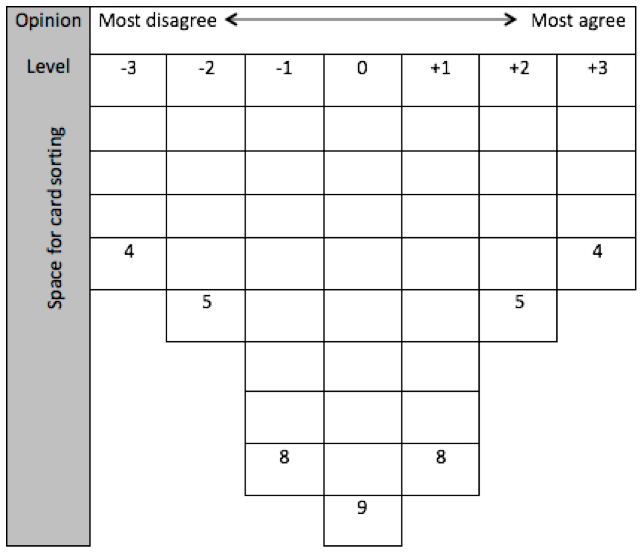
Figure 1. Card sorting example.